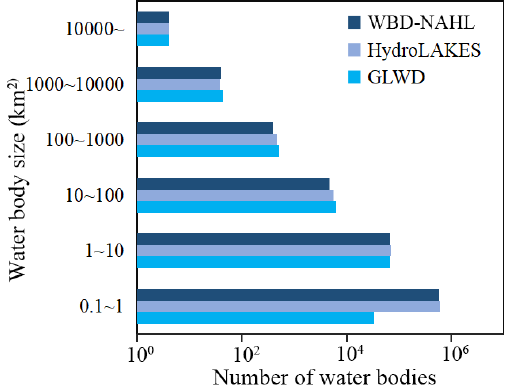
Figure 10. Comparing the number of water bodies identified by WBD-NAHL and other datasets based on size.